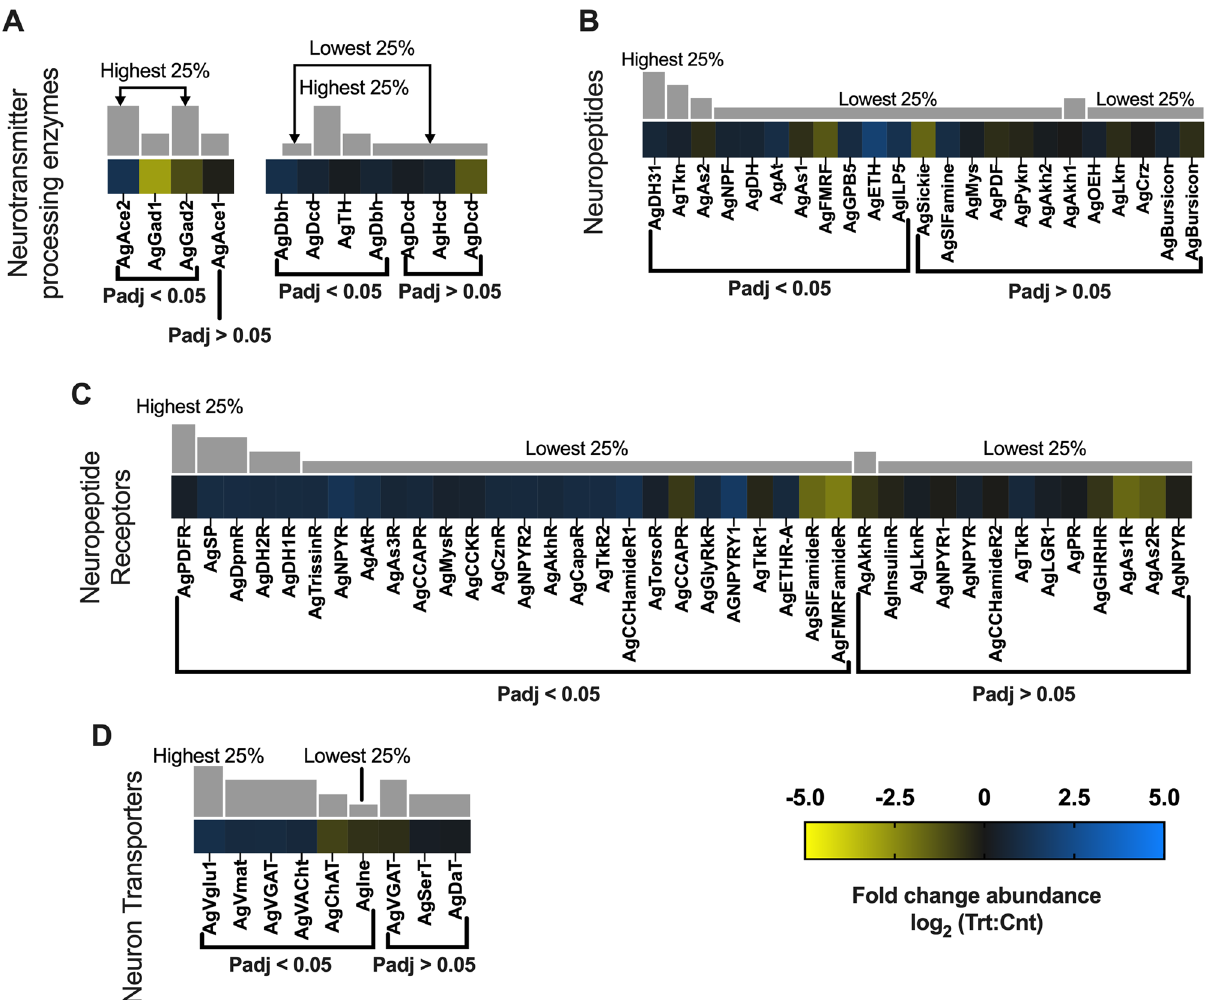
Figure 9. Neuropeptide differential transcript abundances following relevant sporozoite infections. Neuropeptide transcripts that were present at significantly higher (blue) or lower (yellow) levels in Plasmodium falciparum sporozoite infected treatments; non-differentially expressed neuropeptide transcripts are denoted as zeros (black). Neuropeptide genes within each family organized by adjusted p-value and subsequently arrayed left to right from most abundant to least abundant based on FPKM values (quartile bars above each image). ( A ) Neurotransmitter processing enzyme family. ( B ) Neuropeptide family. ( C ) Neuropeptide receptor family. ( D ) Neuron transporter family. Log 2 scale indicates transcript abundances that were significantly higher (blue) or lower (yellow) in sporozoite infected treatments (Trt) vs. naïve controls